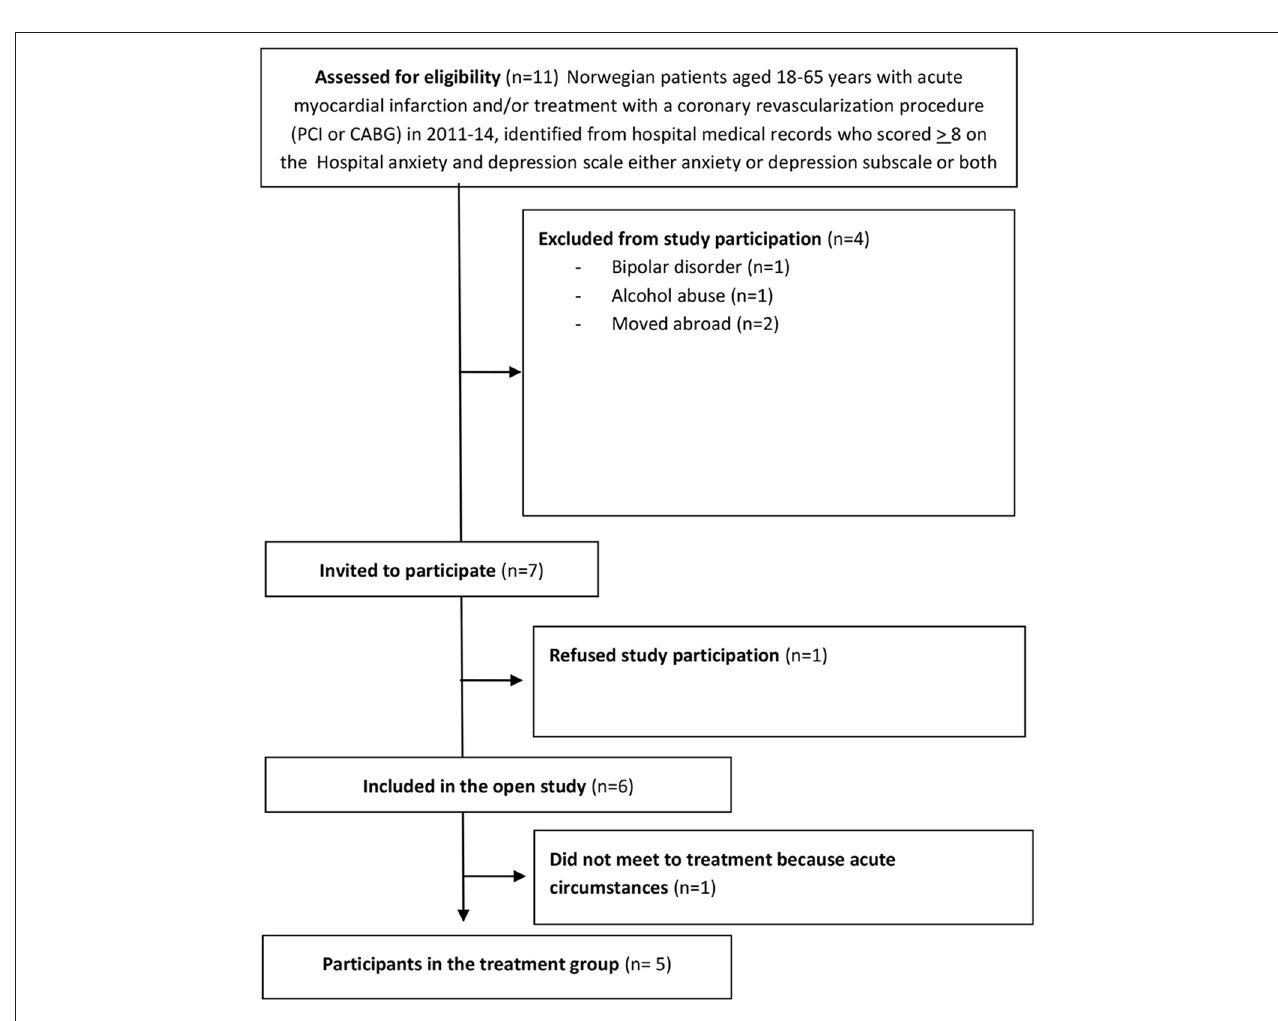
FIGURE 1 | Study flow